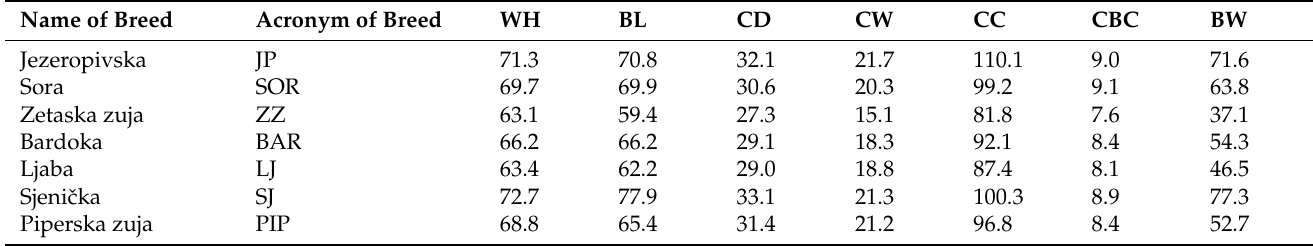
Table 1. The means of body measurements (cm) and body weight (kg) of sheep breeds. WH—wither cannon bone circumference, BW—body weight (Markovic et al. 2020).